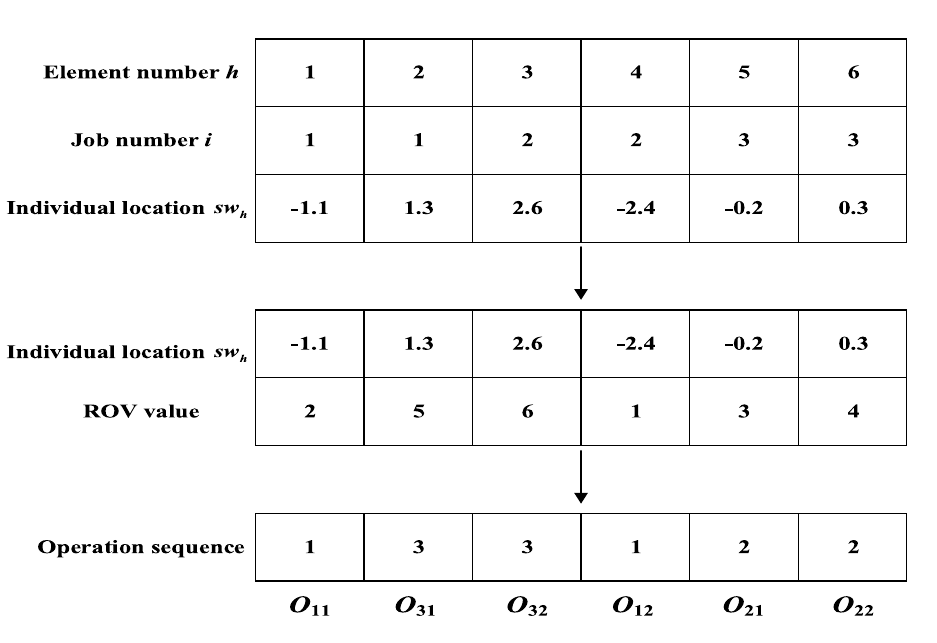
Figure 3. Operation sequence segment